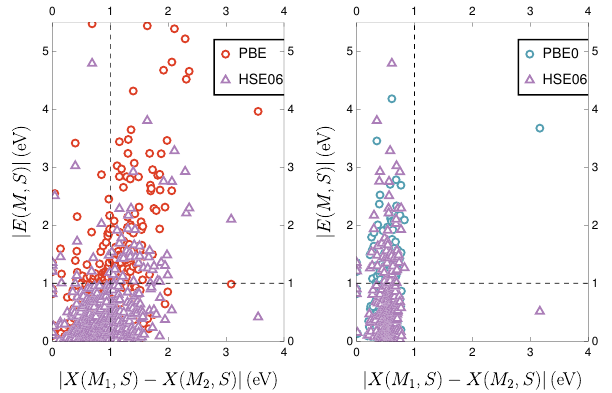
Figure 4. Similarity between HSE06 and PBE (left panel) and PBE0 (right panel) compared to the reliability of the three methods (PBE: red circles, PBE0: blue circles, and HSE06: purple triangles). The points correspond to the absolute errors made by the two methods, | E ( M , S ) | , Equation (2) (on the ordinate) and the distance between the results obtained by the two methods, | X ( M 1 , S ) − X ( M 2 , S ) | , Equation (3) (on the abscissa). The dashed lines exemplify choices for the thresholds for similarity, (cid:101) s , and reliability, (cid:101) r